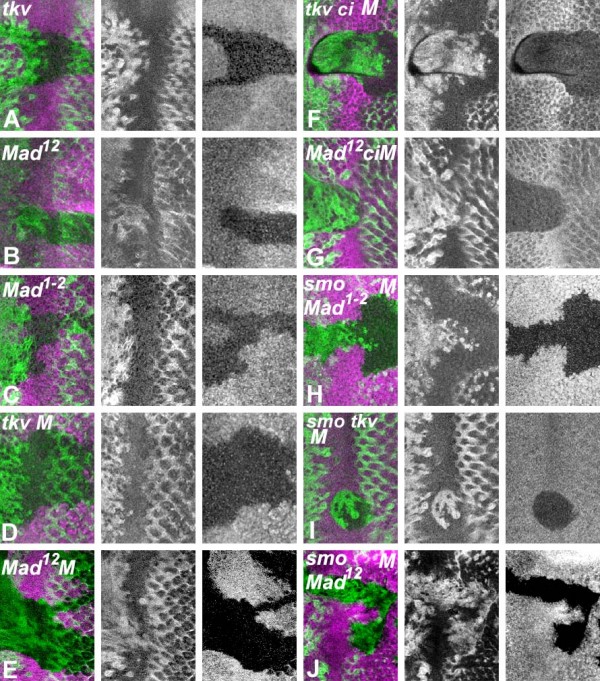
G1 arrest requires Dpp and Hh signal reception. All figures show Cyclin B protein (green) in mutant clones and neighboring wild type regions spanning the morphogenetic furrow, with anterior to the left. Homozygous cells are identified by the absence of β-galactosidase (magenta). (A) tkv4; (B)Mad12; (C) Mad1-2; (D) tkv4 in tkv +/+ M background; (E) Mad12 in Mad +/+ M background; (F) tkv4ci94 in tkv ci +/+ + M background; (G) Mad12ci94 in Mad ci +/+ + M background; (H) smo Mad1-2 in smo Mad +/+ + M background; (I) smo3tkv8 in smo tkv +/+ + M background; (J) smo3Mad12 in smo Mad +/+ + M background. Many of these genotypes have also been examined with anti-pH3 labelling to assess mitotic activity, and BrdU incorporation studies to measure S-phase DNA synthesis, confirming the results obtained with CycB labeling in all cases [26](data not shown).